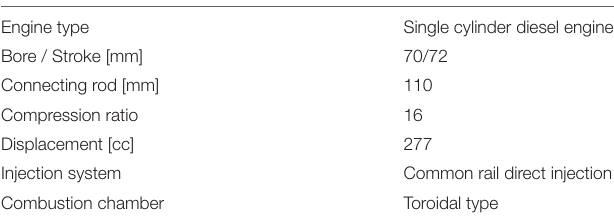
TABLE 1 | The engine specifications for visualization